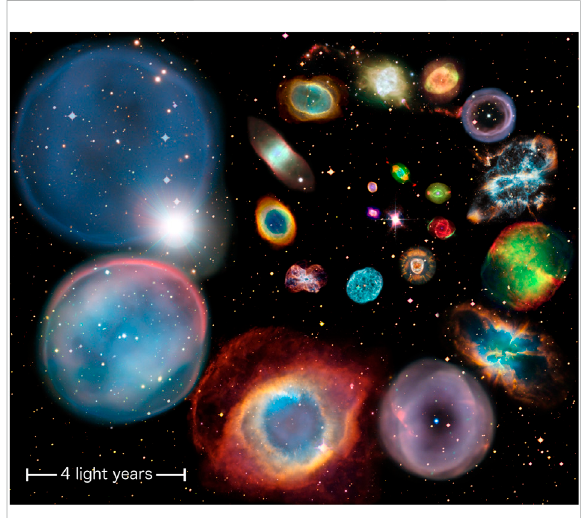
FIGURE 1 A now iconic collage showing 22 individual well-known PNe, artistically arranged in a spiral pattern by order of approximate physical size. Each nebula ’ s size is calculated from the SB-r statistical distance scale from Frew et al. (2016). It can be applied to PNe exhibiting the entire range of surface brightness, morphology and size. The largest PNe have a surface brightness about a hundred thousand times fainter than the smallest and can reach up to 3 pc across. General image credit: ESA/Hubble and NASA, ESO, NOAO/AURA/NSF from an idea by the author and Ivan Boji č i ć and rendered by Ivan Boji č i ć with input from David Frew and the author. The names of all these iconic PNe in the fi gure starting at the top left hand corner and following the spiral are: Abell 33, K 1 – 22, NGC 7293, IC